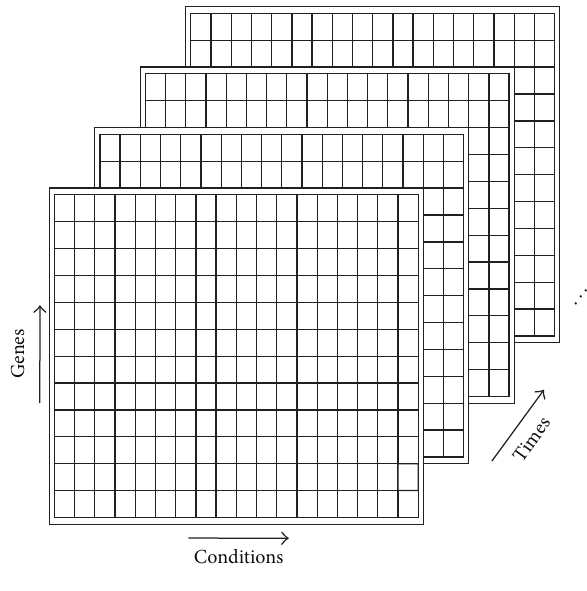
Figure 1: Tricluster